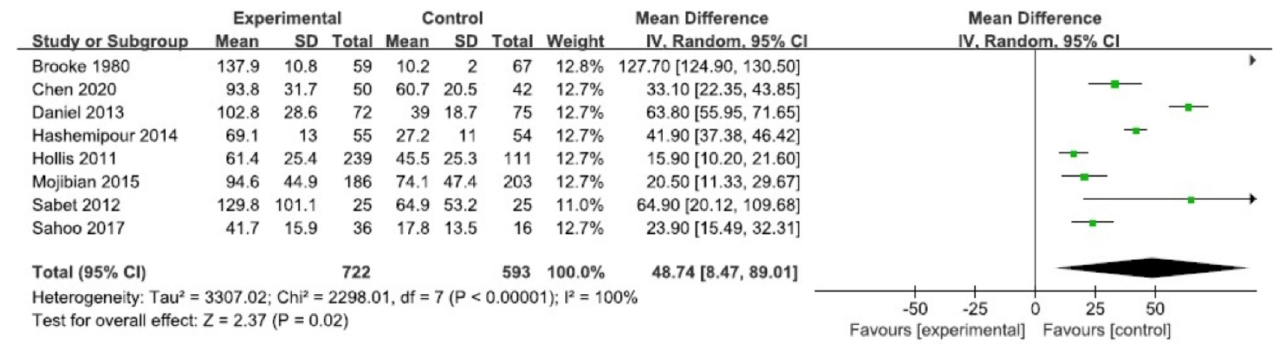
Fig 5. Forest plots of summary crude risk ratios of the association between vitamin D supplementation during pregnancy in the offspring cord blood 25 (OH)D concentration.